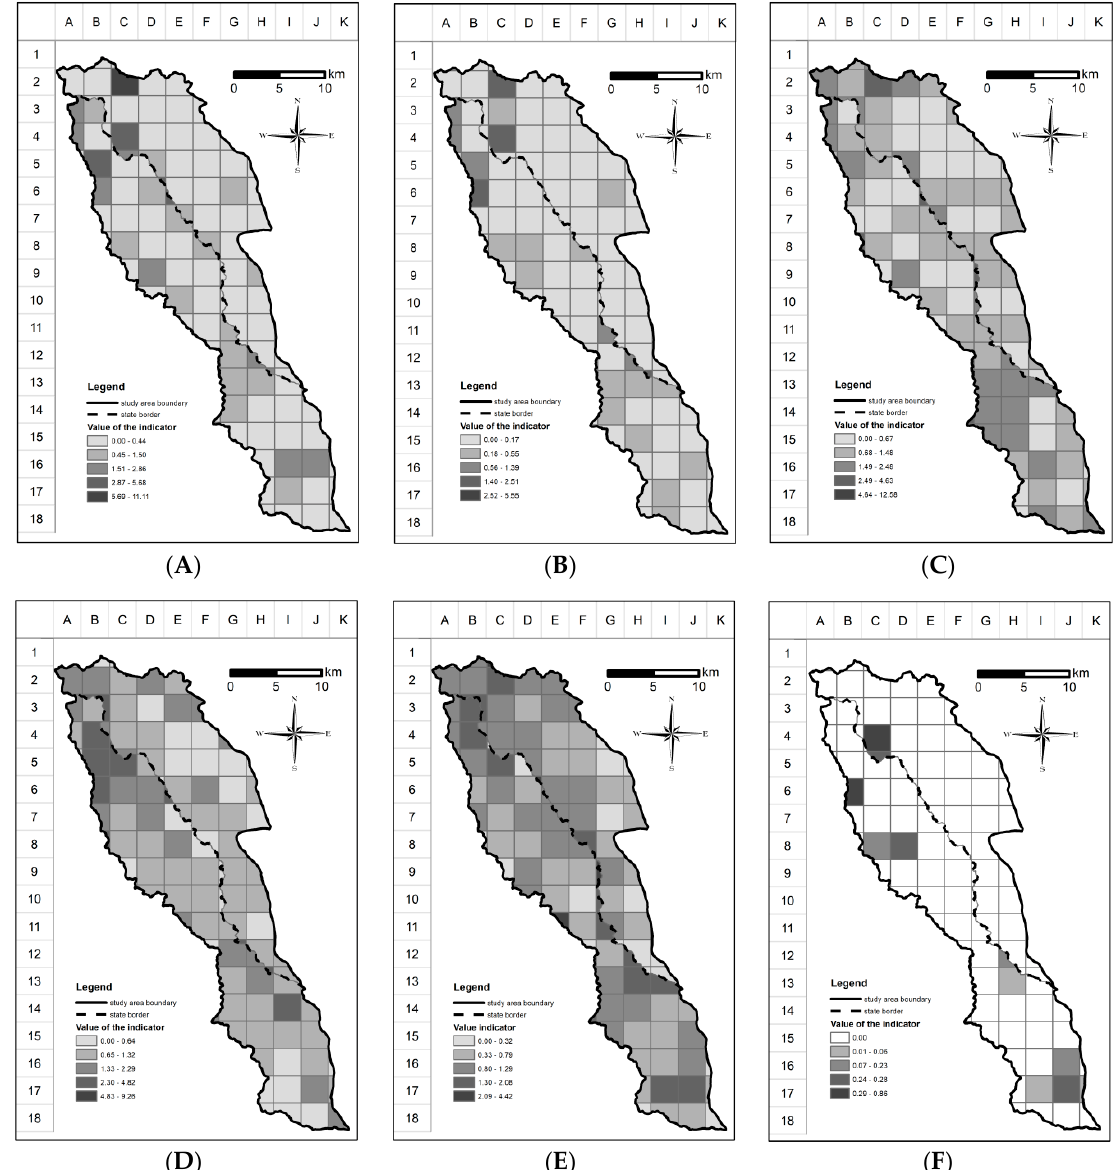
Figure 5. The density of the analyzed tourism infrastructure in the study area (square grid): ( A ) accommodation facilities; ( B ) gastronomic facilities; ( C ) roads; ( D ) marked hiking trails; ( E ) marked cycle trails; ( F ) ski lifts. Source: authors’ own research.